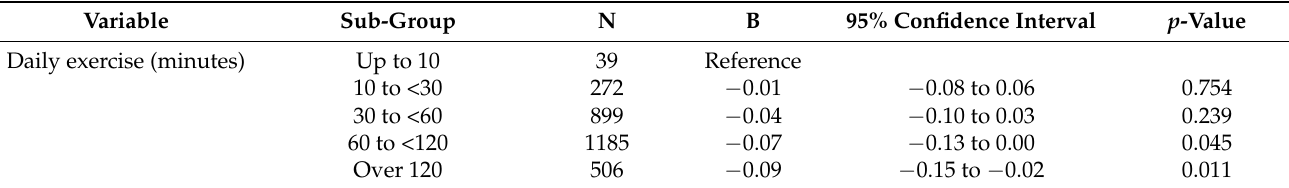
Table 6. Variables influencing owner perception of summer weather effects on canine activity score, variables with a positive B value increased the summer weather effects score and factors with a negative B value decreased the summer effects